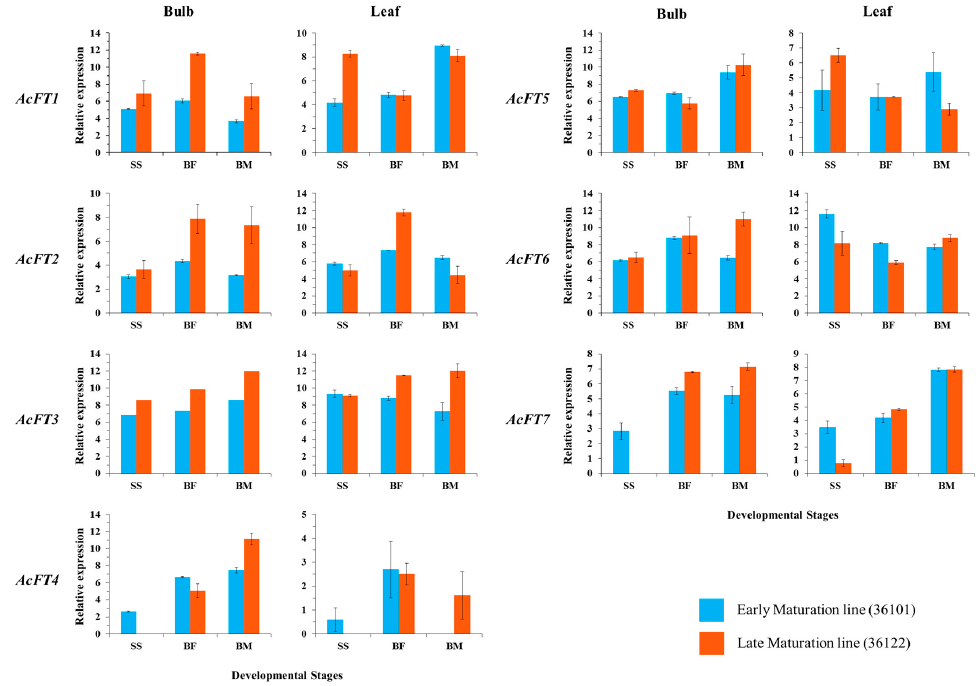
Figure 3. Expression of AcFT genes in EM (early maturation, 36101) and LM line (late maturation, 36122), leaf and bulb tissues were harvested during three stages: seedling stage (SS), Bulb formation (BF) and Bulb maturation (BM). Data represent an average ± s.e.m of three biological replicates, with transcripts normalized to β -tubulin .